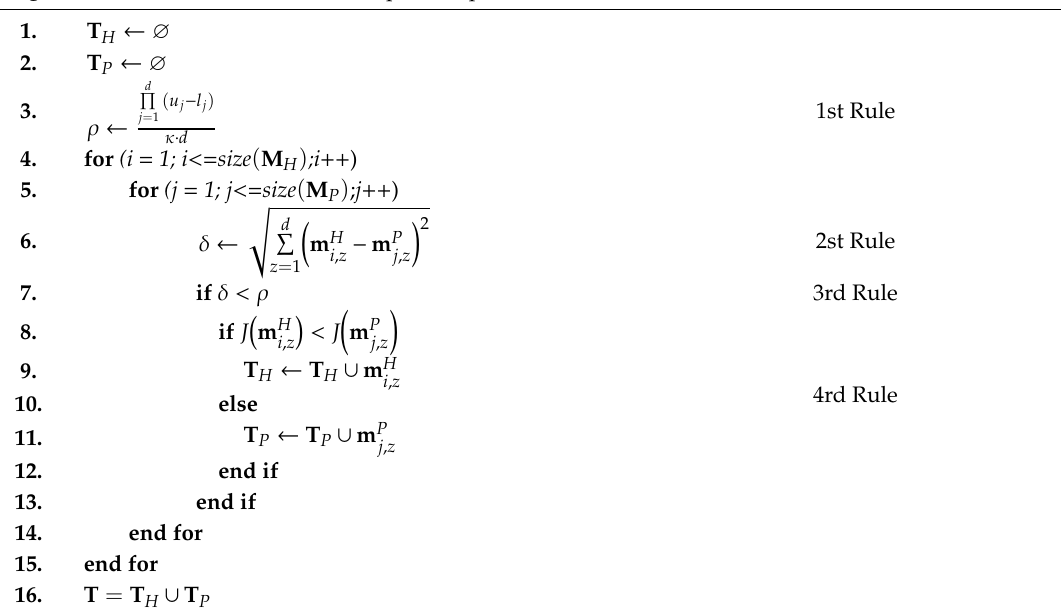
Algorithm 2. Pseudo-code for the competition phase.